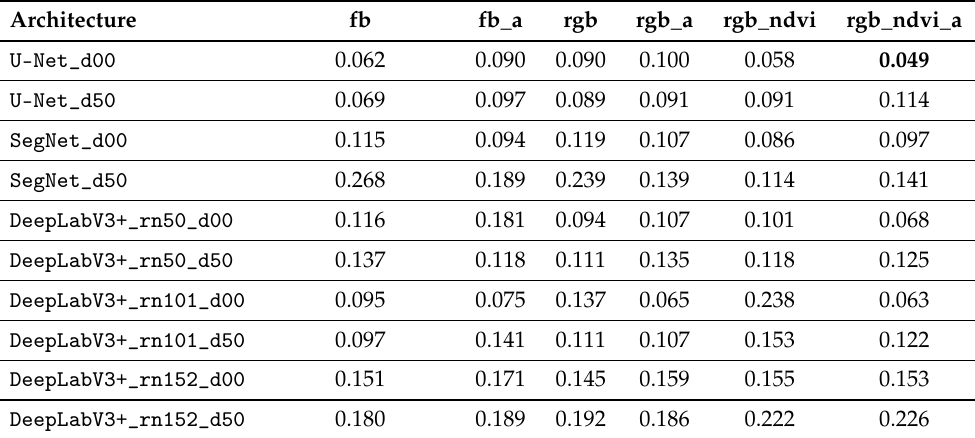
Table 3. Binary cross entropy loss values over the validation dataset for different architectures and settings on the binary dataset. For rows: dN% stands for dropout, N specifies the dropout ratio, and rnN specifies the ResNet version used as a backbone model for DeepLabV3+. For columns: fb stands for the dataset utilizing the full-band images, rgb stands for the dataset utilizing only the red, green, and blue bands, rgb_ndvi represents rgb enhanced by the NDVI, and _a represents the augmented version of the dataset.